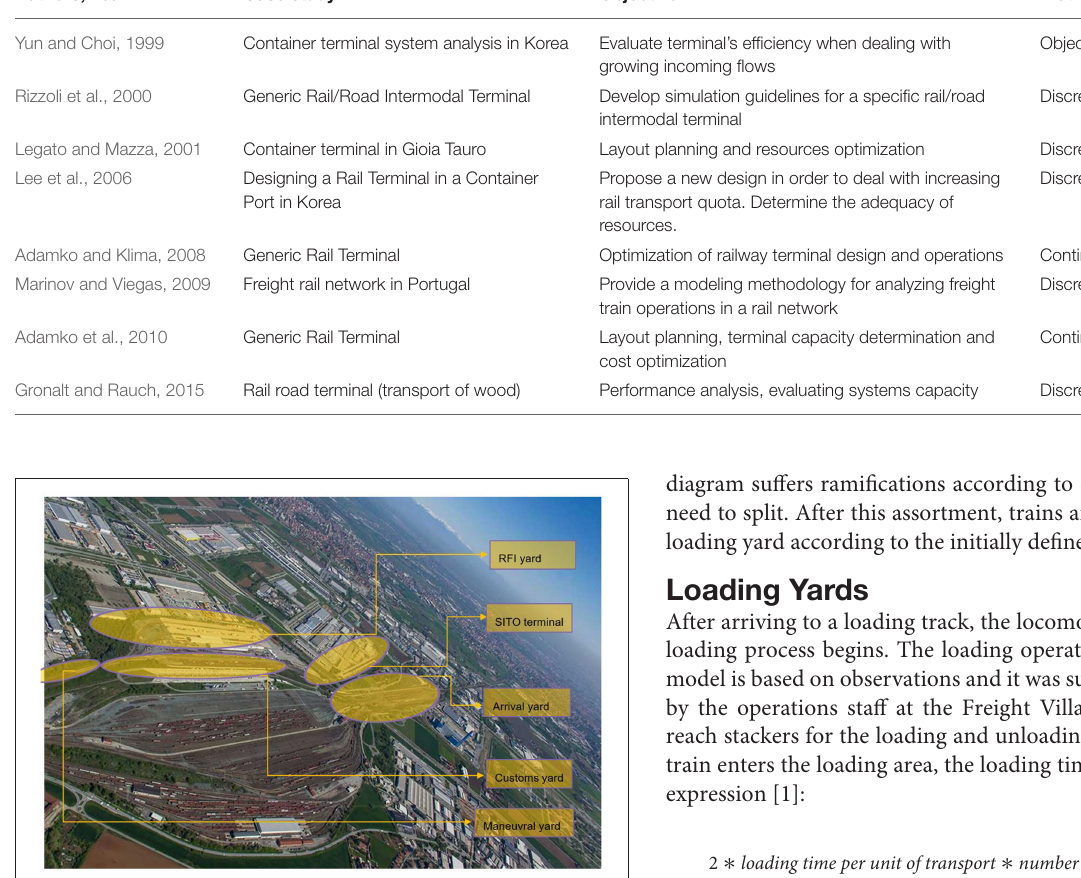
TABLE 1 | A summary of simulation studies regarding sea ports and intermodal terminals. Authors,